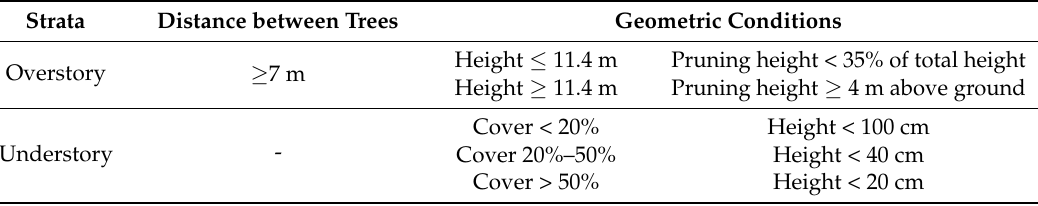
Table 3. Geometric requirements for biomass management strips, established by the Galician wildfire prevention law